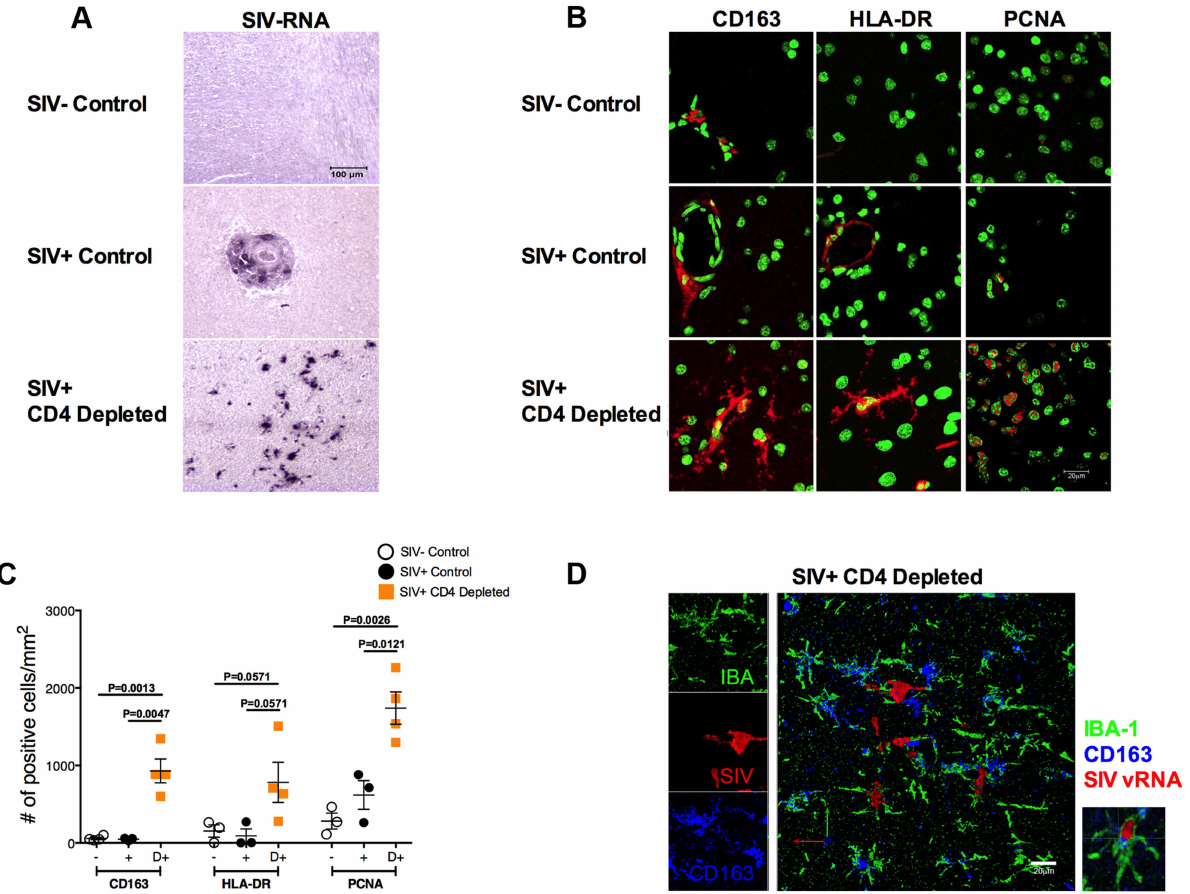
Figure 5. Massive activation and productive infection of microglia in CD4-depleted RMs. ( a ) ISH showing the levels of SIV vRNA + cells in brain from a representative SIV-uninfected control (top), SIV-infected control (middle) and CD4-depleted SIV-infected (bottom) animal. The amount of SIV vRNA + cells was markedly higher in CD4-depleted animals than in controls. ( b ) Immunofluorescence staining for CD163 (left panels), HLA-DR (middle panels) and proliferating cell nuclear antigen (PCNA; right panels) in the parenchyma of one representative SIV-uninfected control (top), one SIV-infected control (middle) and one SIV-infected CD4-depleted (bottom) RM. Nuclei are stained in green; markers of interest in red. ( c ) Quantitative analyses showing the number of cells per mm 2 of tissue that stained positively for the markers of interest. Increased expression of CD163, HLA-DR and PCNA was found in CD4-depleted animals (orange square; n=4) when compared to both groups of controls (SIV- open circle, n=3; SIV + closed circle, n=3). ( d ) Single and combined staining for IBA-1 (green), CD163 (blue), and SIV-vRNA (red) in the brain of one representative SIV-infected CD4 depleted RM. The box on the right is a magnification of a microglial cell (IBA-1 + ) that expresses CD163 and is productively infected (SIV vRNA + ).